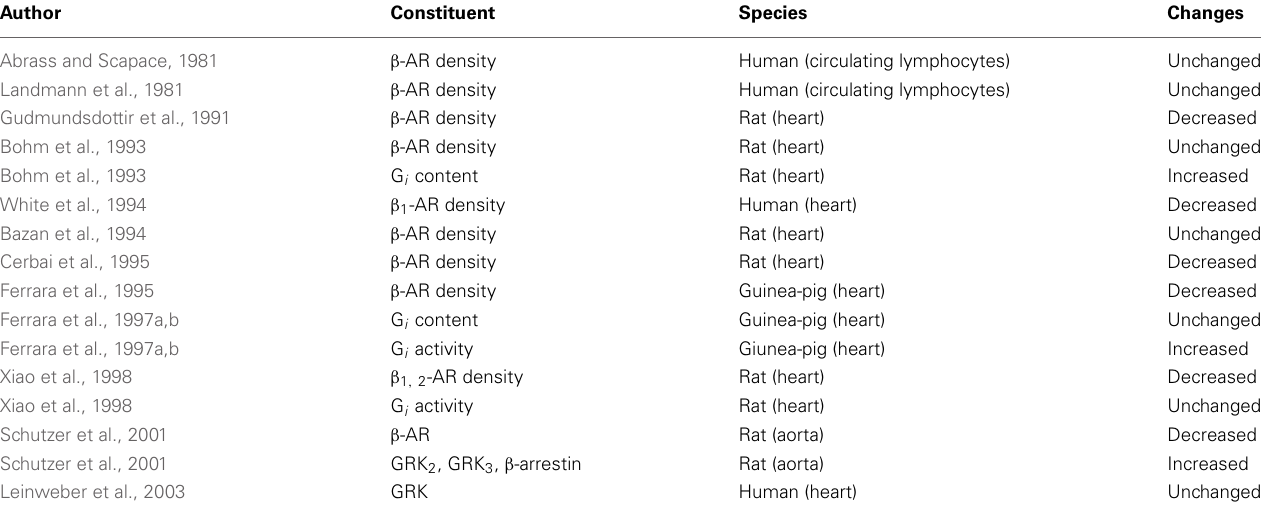
Table 1 | Cardiovascular system: the main general age-related changes in β -adrenergic